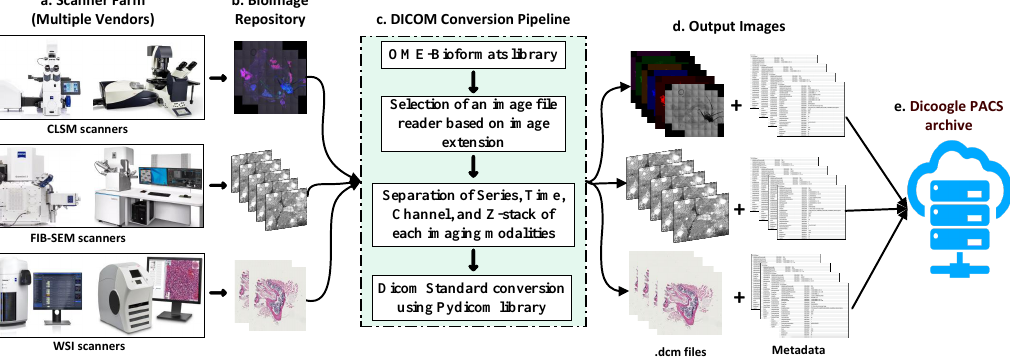
Figure 2. Overview of the proposed pipeline for the conversion of CLSM, WSI, and FIB-SEM microscope imaging modalities into the standard